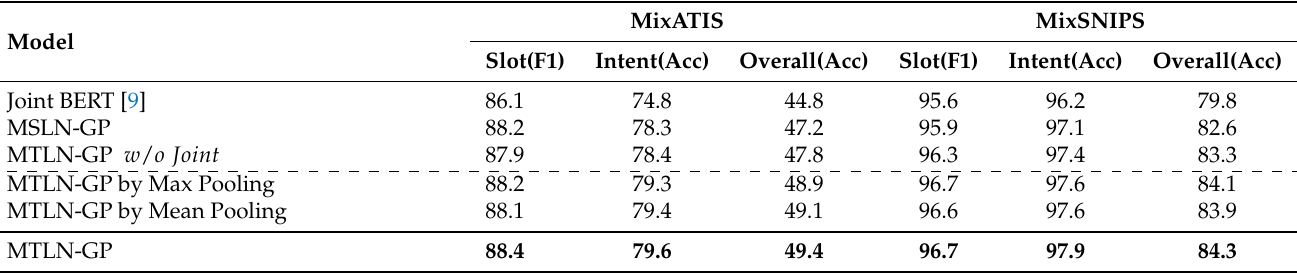
Table 4. On two multi-intent datasets, we conducted an ablation comparison of our proposed approach